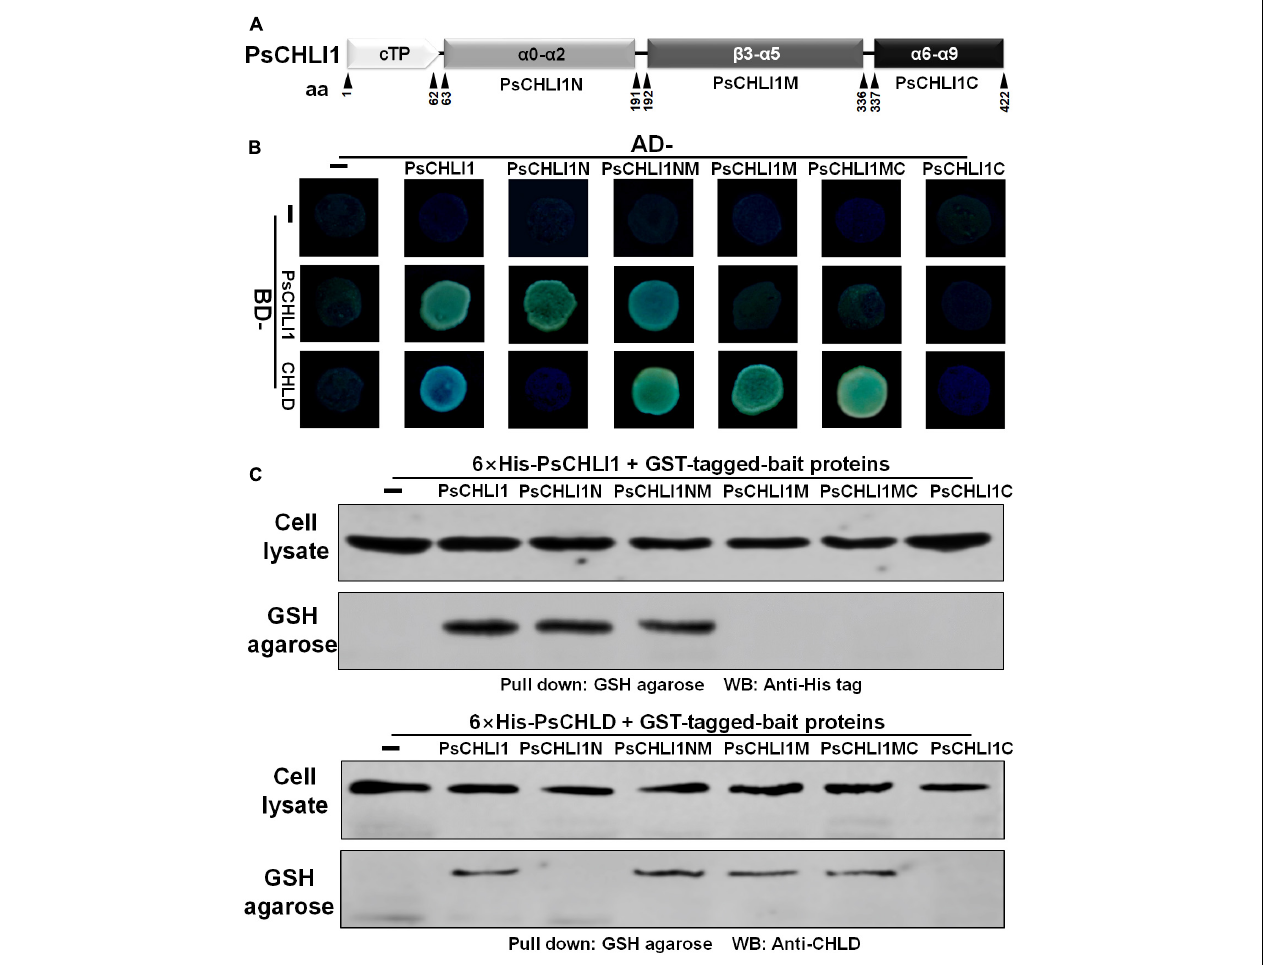
FIGURE 5 | Peptide fragments of PsCHLI1 for protein-protein interactions. (A) Four peptide fragments of PsCHLI1. The amino acid positions (aa) are indicated below the elements. Secondary structure elements in the different peptide fragments are shown in the boxes. α , α -helices; β , β -sheets. The interactions between PsCHLI1 or PsCHLD and the different fragments of PsCHLI1 were determined by the yeast two-hybrid assay (B) and glutathione S transferase (GST) pull-down assay (C) . cTP, chloroplast transit peptide; PsCHLI1N, the N-terminal fragment of PsCHLI1; PsCHLI1M, the middle fragment of PsCHLI1; PsCHLI1C, the C-terminal fragment of PsCHLI1; PsCHLI1NM, PsCHLI1N fused with PsCHLI1M; PsCHLI1MC, PsCHLI1M fused with PsCHLI1C; GSH,